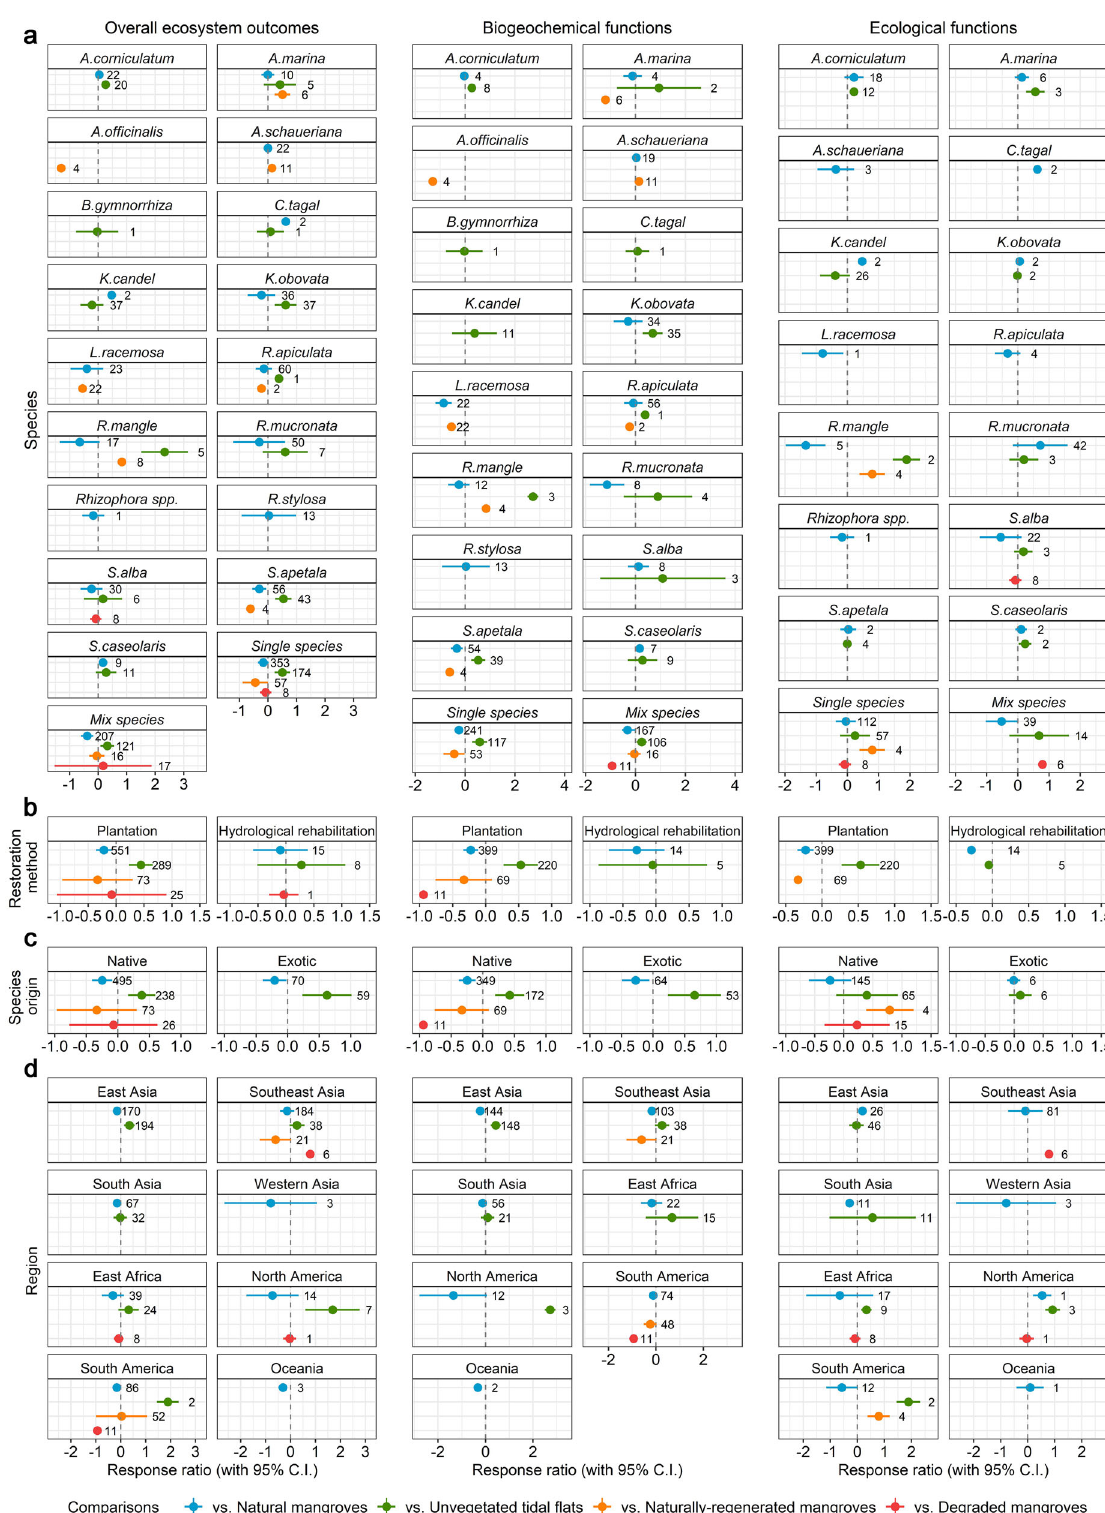
Fig. 3 Subgroup analyses. Panel a species, b restoration method, c species origin and d region. Bars around the means denote 95% CIs. The numbers at the right side of the con fi dence intervals denote the number of observations. If a bar falls in the positive side and does not intersect with zero we interpret that the restored mangrove provides this speci fi c function at a higher level than the comparative basis, and the opposite if it falls in the negative side of the forest plot. Source data are provided as a Source Data fi